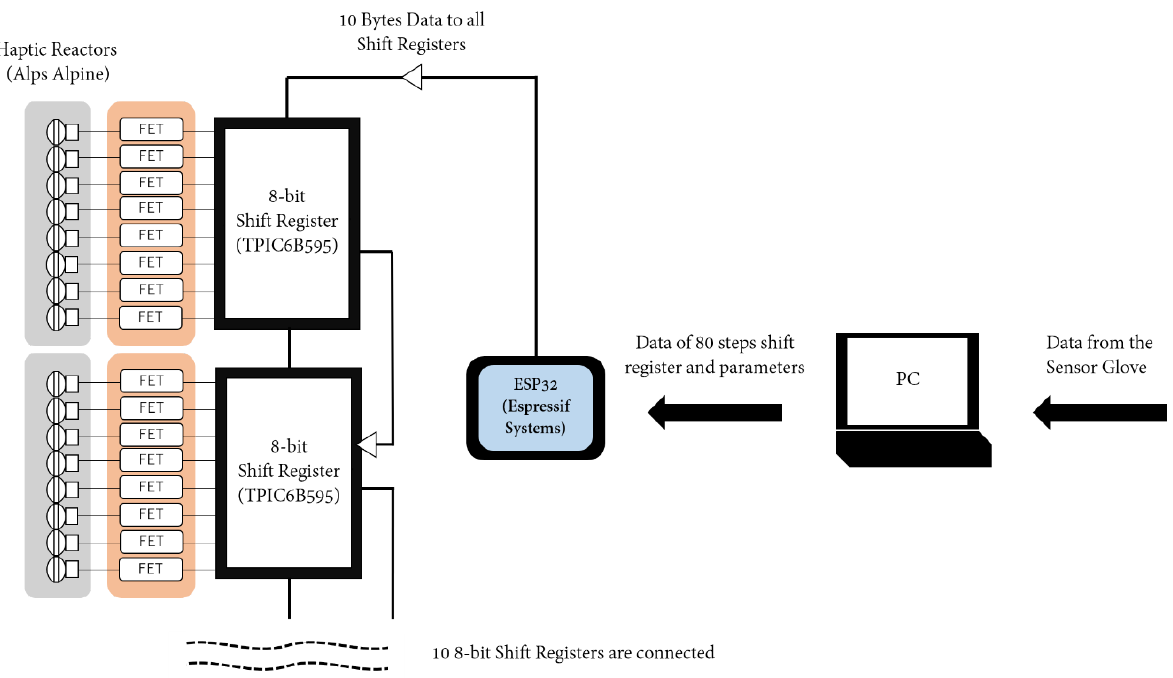
Figure 3. Hardware configuration of the haptics vest.